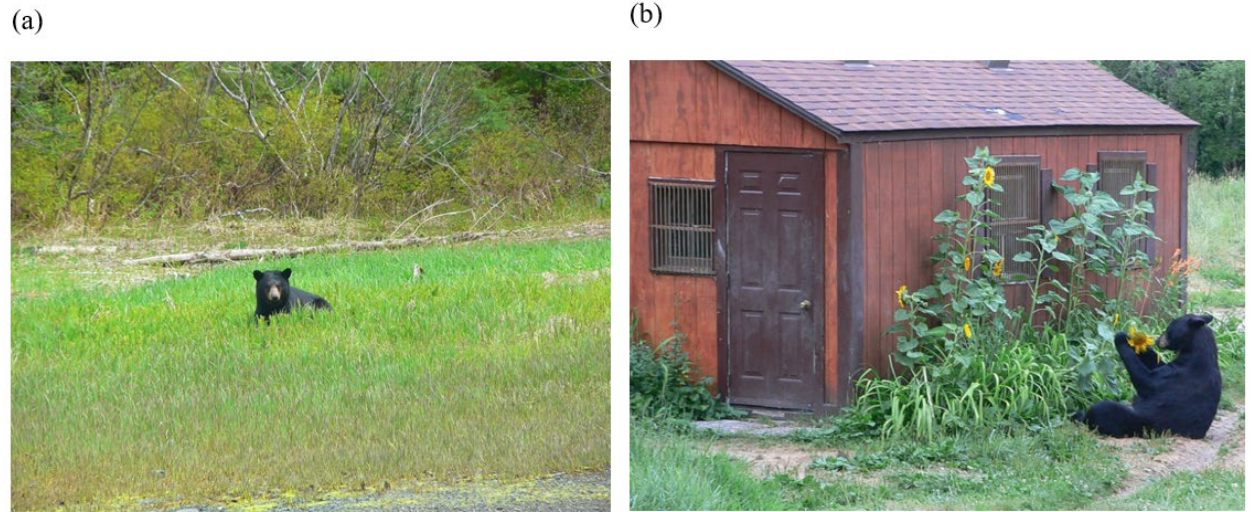
Figure 7. American black bears are attracted to concentrated food sources, such as ( a ) lush sedge along the shoreline of a coastal bay and ( b ) a small garden of sunflowers. Most habitat use studies are unlikely to be able to measure either use or availability at such a small scale, and moreover, the short time feeding at such places greatly underestimates the attraction to and importance of these food sources. Photos: D. Garshelis.